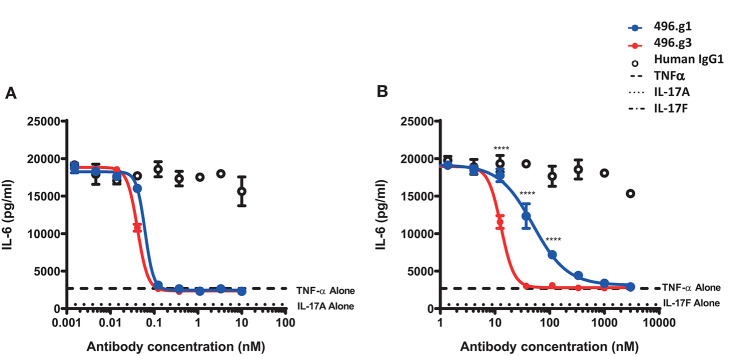
Inhibition of IL-6 production from normal human dermal fibroblasts (NHDFs) stimulated with TNF in combination with IL-17A or IL-17F by IL-17-specific antibodies. (A) IL-17A (0.15 nM) or (B) IL-17F (25 nM) in combination with TNFα (0.025 nM) was pre-incubated with titrations of 496.g1, 496.g3 or an irrelevant antigen-specific human IgG1 isotype control for 1 h before addition to cells. NHDFs were subsequently stimulated for 18–20 h before IL-6 protein levels in the supernatant were determined by homogeneous time-resolved fluorescence. As shown in both figures, stimulation of NHDFs by TNF or IL-17A or IL-17F individually failed to elicit sufficient production of IL-6. Each condition was tested in duplicate and the data shown is representative of three separate experiments. Two-way ANOVA, Bonferroni post-test analysis was performed to compare inhibition of 496.g1 vs. 496.g3 (*p < 0.05, **p < 0.01, ***p < 0.001, ****p < 0.0001).